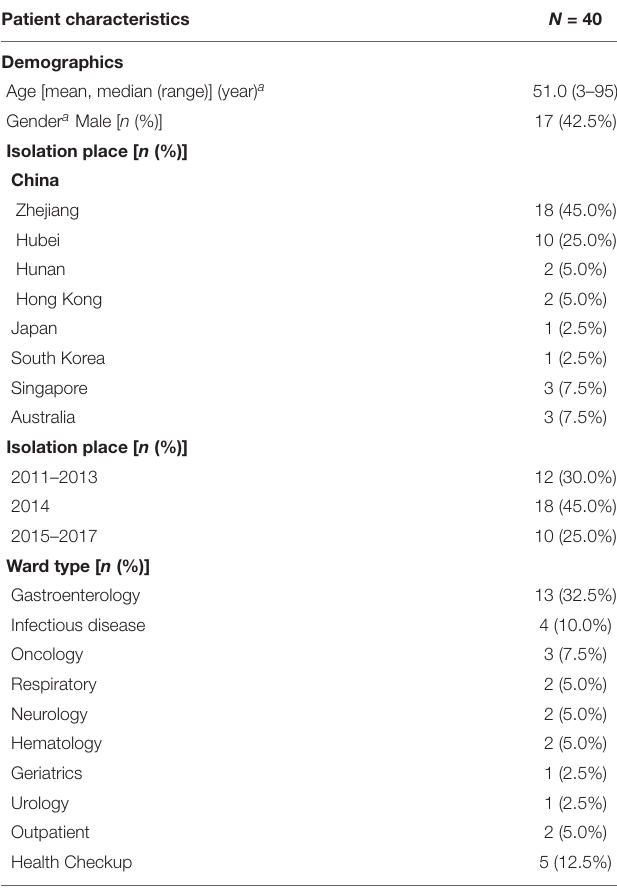
TABLE 1 | Clinical information of 40 C. difficile ST2 isolate. Patient